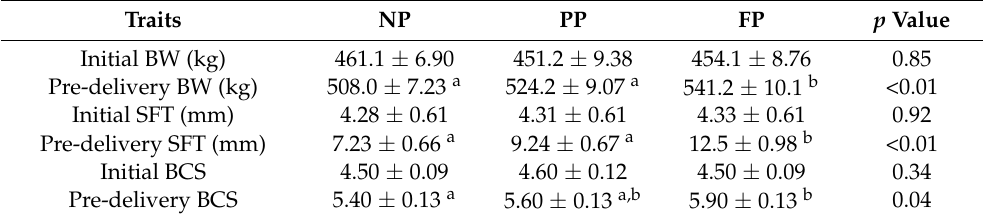
Table 6. Average of BW (kg), subcutaneous fat thickness (SFT; mm) and body condition score (BCS) ± standard error of the mean of Nellore cows submitted to different maternal nutrition ap- proaches (NP, PP and FP) with their respective p values. Traits NP PP FP p Value Initial BW (kg) 461.1 ± 6.90 451.2 ± 9.38 454.1 ± 8.76 0.85 Pre-delivery BW (kg) 508.0 ± 7.23 a 524.2 ± 9.07 a 541.2 ± 10.1 b <0.01 Initial SFT (mm) 4.28 ± 0.61 0.92 Pre-delivery SFT (mm) 7.23 ± 0.66